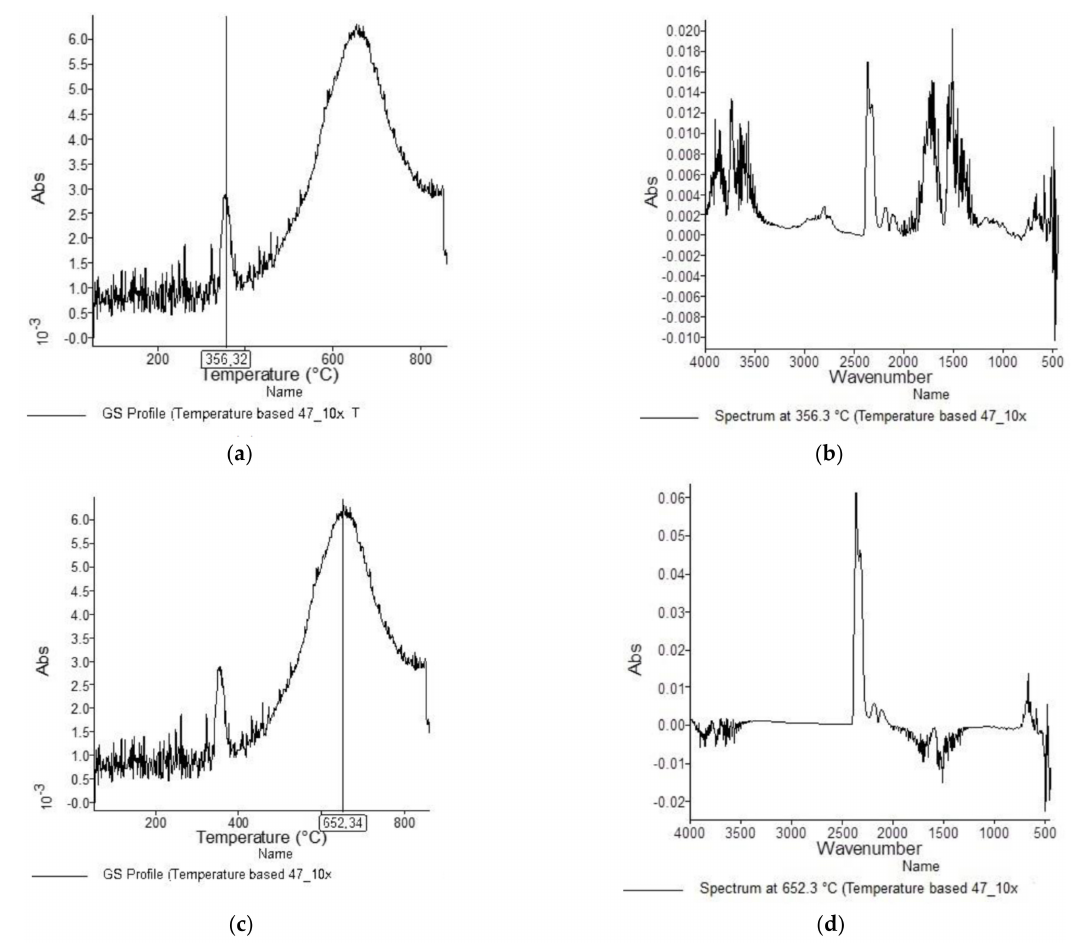
Figure 6. TG–IR analysis of 47_10x during thermo-oxidative decomposition: ( a ) and ( c ) intensity profile FT–IR spectrum of gas evolved, ( b ) FT–IR spectrum of gas evolved at 356.3 ◦ C, ( d ) FT–IR spectrum of gas evolved at 652.3 ◦ C.